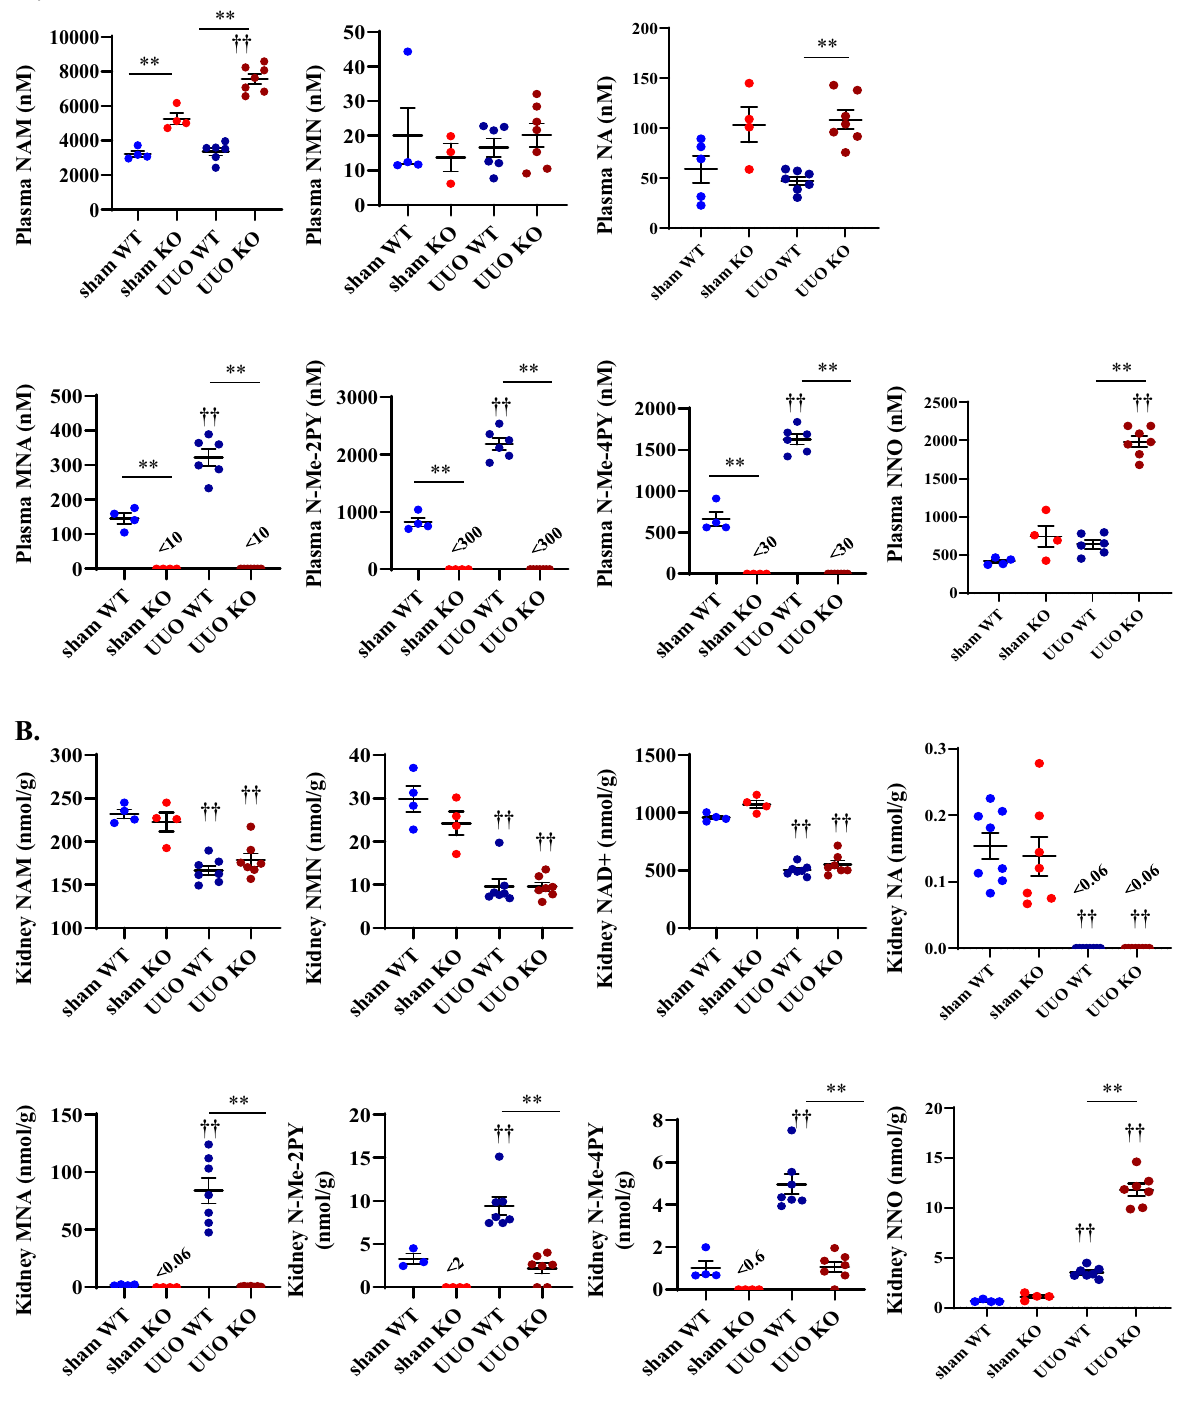
Figure 4. NNMT deficiency decreases renal N-Me-2PY and N-Me-4PY and increases SAM/SAH ratio in UUO, thereby increasing the methylation capacity of CTGF . Plasma NAD + metabolites ( A ) and renal NAD + metabolites ( B ) were measured in NNMT-KO mice and WT littermates after UUO induction. The values shown are means ± SEM ( n = 4–8 per group). ( C ) SAM levels, SAH levels, and SAM/SAH ratios in the kidneys of NNMT-KO mice and WT littermates after UUO induction. The data represent means ± SEM ( n = 8 per group). ( D ) Bisulfite sequencing of CTGF CpG islands. Each circle indicates a CpG site in the sequence, and each line of circles represents a single cloned allele. Open circles, unmethylated CpG sites; closed circles, methylated CpG sites. UUO, unilateral ureter obstruction; NNMT, nicotinamide N-methyltransferase; NAM, nicotinamide; NMN, nicotinamide mononucleotide; NAD + , nicotinamide adenine dinucleotide; MNA, 1-methylnicotinamide; N-Me-2PY, N-methyl-2-pyridone-5-carboxamide; N-Me-4PY, N-methyl-4-pyridone-3-carboxamide; NA, nicotinic acid; NNO, nicotinamide-N-oxide; SAM, S-adenosylmethionine; SAH, S-adenosylhomocysteine; CTGF, connective tissue growth factor. * P < 0.05, ** P < 0.01 versus WT mice. † P < 0.05, †† P < 0.01 versus the same genotype control mice (sham-operated